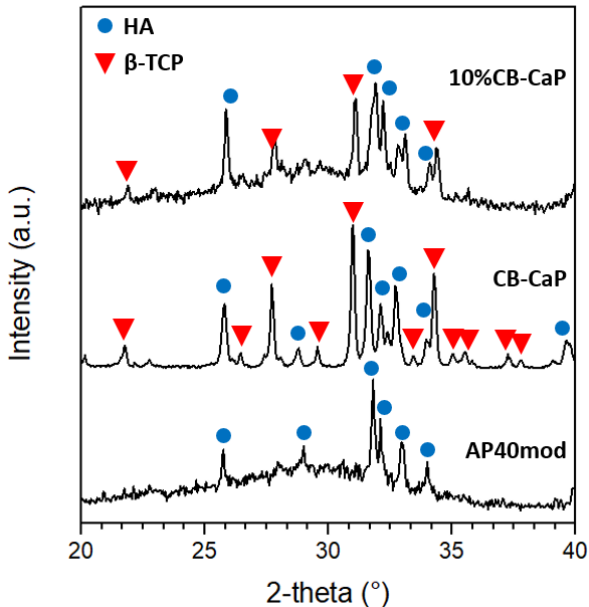
Figure 3. XRD spectra of AP40mod, CB-Ca-P and AP40mod/10 wt% CB-CaP mixture.